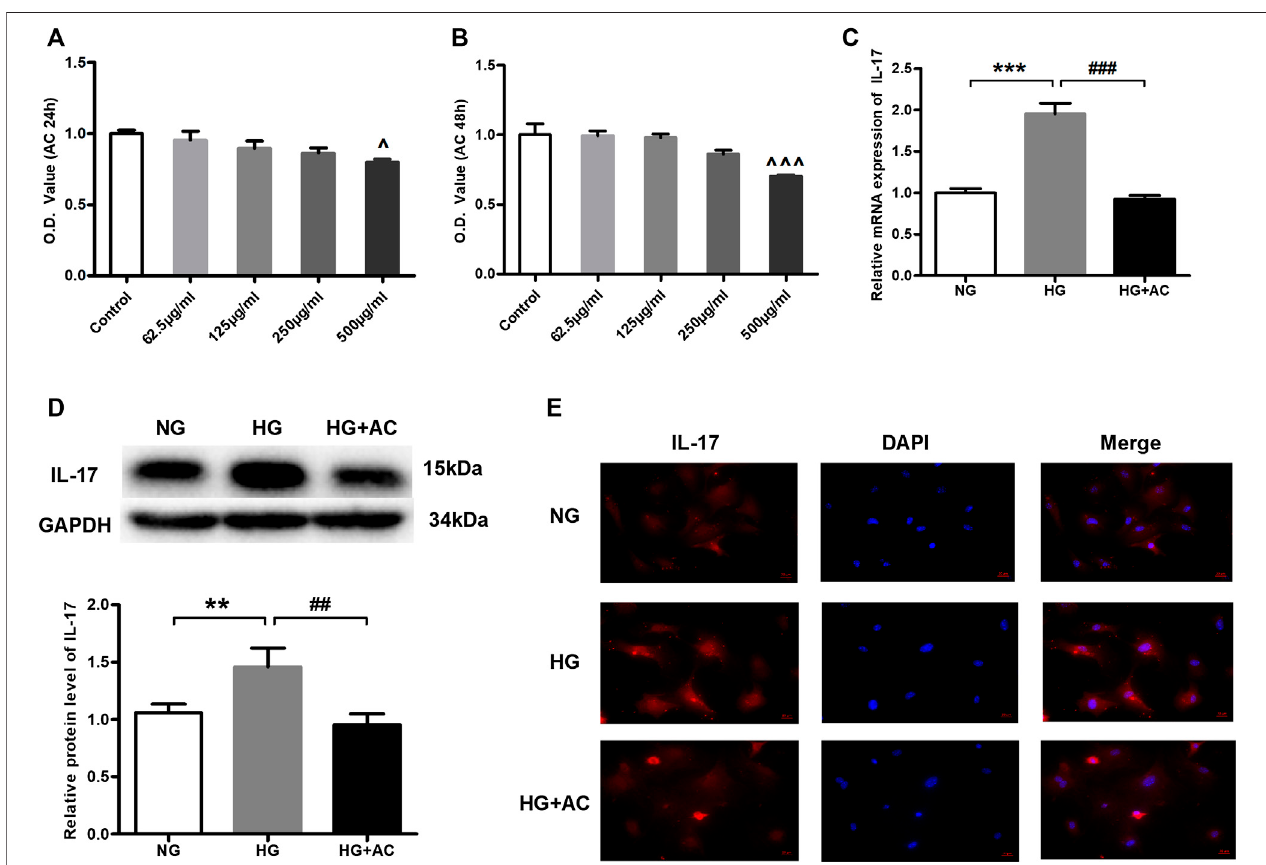
FIGURE3| Anthocyaninrepresseshighglucose-inducedabnormalupregulationofinterleukin(IL)-17expressionincardiac fi broblastsisolatedfromneonatalmice. (A) Alterations in viability at 24 h. (B) Alterations in viability at 48 h. (C) Relative expression of IL-17 mRNA detected using quantitative reverse transcription PCR (qRT- PCR). (D) Expression of IL-17 protein. GAPDH served as an internal control. (E) Immuno fl uorescence staining of IL-17. Scale bar, 20 μ m. ^ p < 0.05 vs. Control, ^^ p < 0.01 vs. Control, ^^^ p < 0.001 vs. Control, *** p < 0.001 vs. NG, ### p < 0.001 vs. HG. NG, normal glucose (5.5 mM); HG, high glucose (25 mM); HG + AC, high glucose (25 mM) + anthocyanin (250 μ g/ml); n (cid:1) 5 for A-C, n (cid:1) 3 for